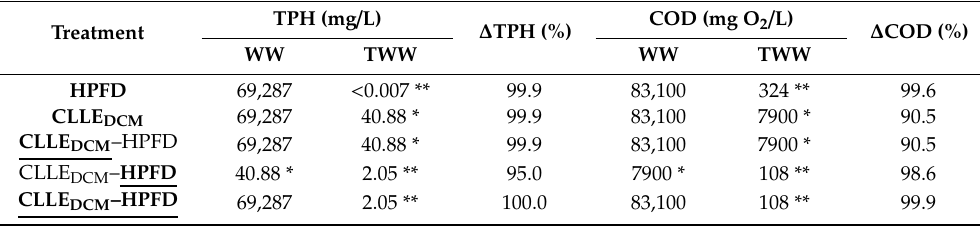
Table 4. Decrease of total petroleum hydrocarbon (TPH) and chemical oxygen demand (COD) by HPFD, CLLE DCM , or CLLE DCM –HPFD (on a laboratory scale) in the nondomestic wastewater sampled in the sedimentation pond of the petroleum production area (WW).